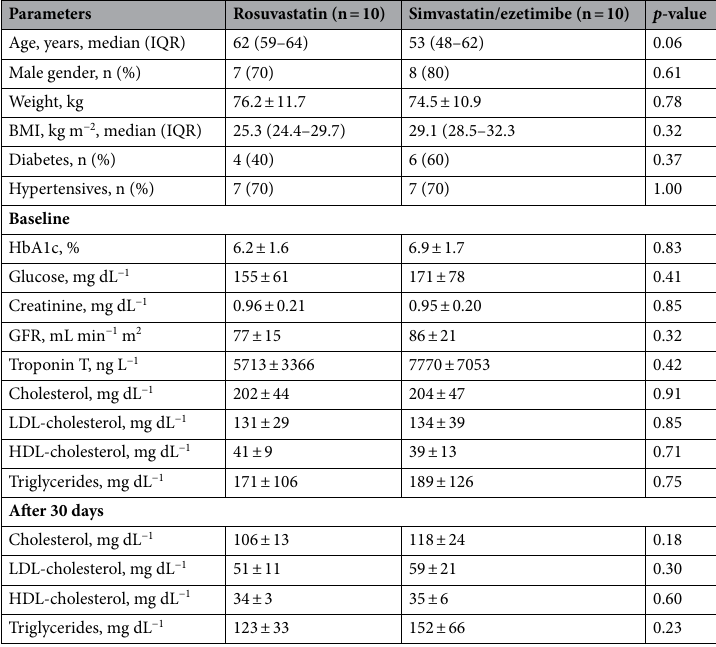
Table 1. Characteristics of the study population and classic lipid profile at baseline and after treatment. Data are mean ± SD unless otherwise stated. Comparisons were examined by unpaired Student´s t test or by the non-parametric Mann–Whitney U test. Categorical variables were tested by Pearson’s Chi-square test. BMI body mass index, HbA1c glycated hemoglobin, GFR glomerular filtration